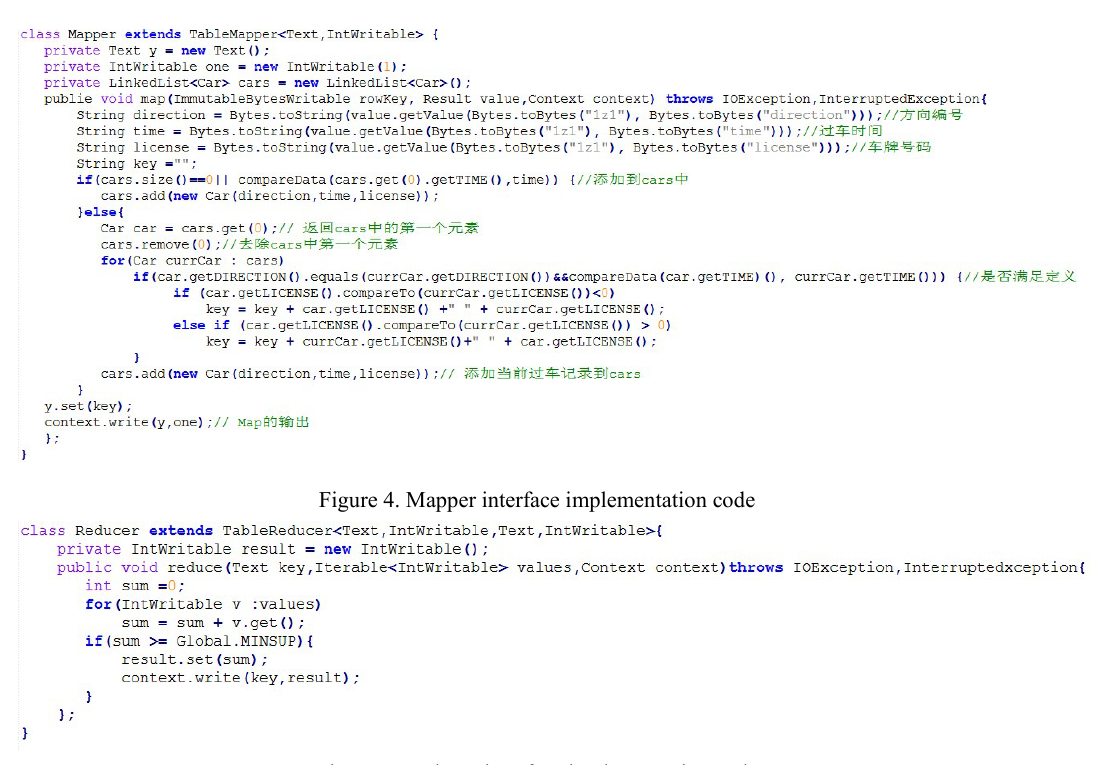
Figure 5. Reducer interface implementation